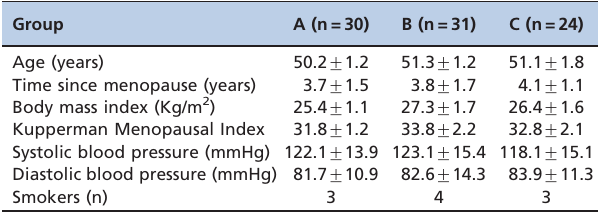
Table 1 - Characteristics of the participants (mean ¡ standard deviation) in all groups at baseline: A (unopposed estrogen), B (estrogen-progestin combination) and C (placebo). Group